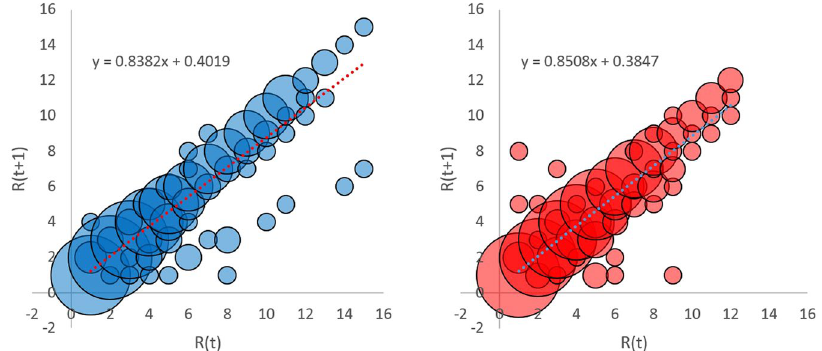
Figure 1. Social mobility in terms of rank at time t (R(t)) and rank a year later (R(t + 1)) for the same individuals (left: males, N = 182 individual-years; right: females, N = 192 individual-years). The regression equation for the dotted line in each panel shows the relationship in rank between two consecutive years. Note the number of overlapping data points is proportional to the size of the